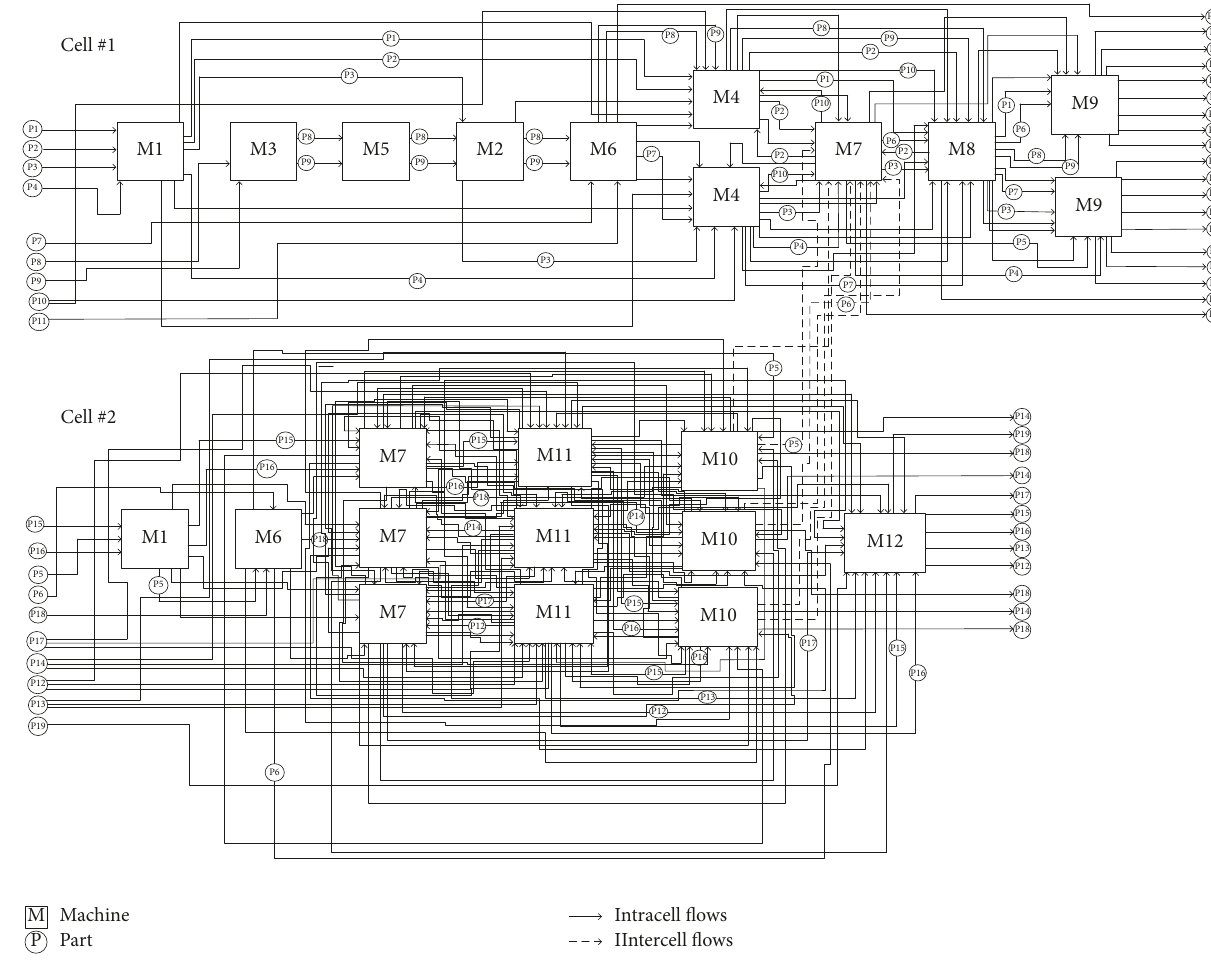
Figure 9: MPC1 and its part flows divided into 2 cells.